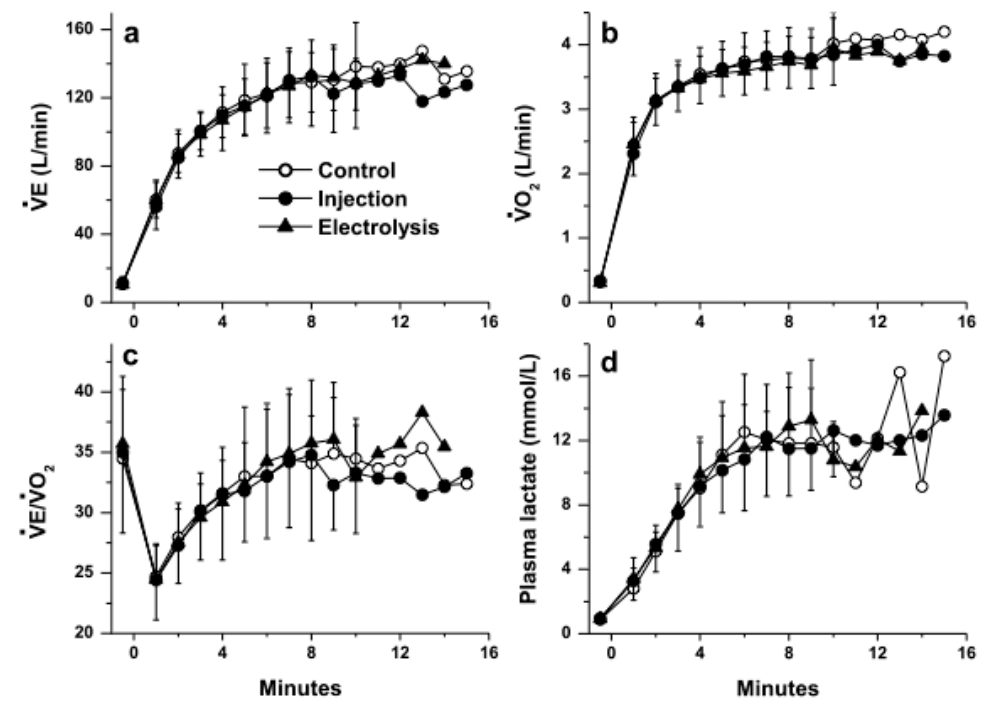
Figure 1. Pulmonary responses during exercise: ( a ) pulmonary ventilation (VE), ( b ) oxygen uptake (VO 2 ), ( c ) ventilatory equivalent of oxygen and ( d ) plasma lactate concentration with the three waters (mean ± SD; SD not shown past min 10 because n < 5; no significant difference was observed between the three waters, p > 0.05).